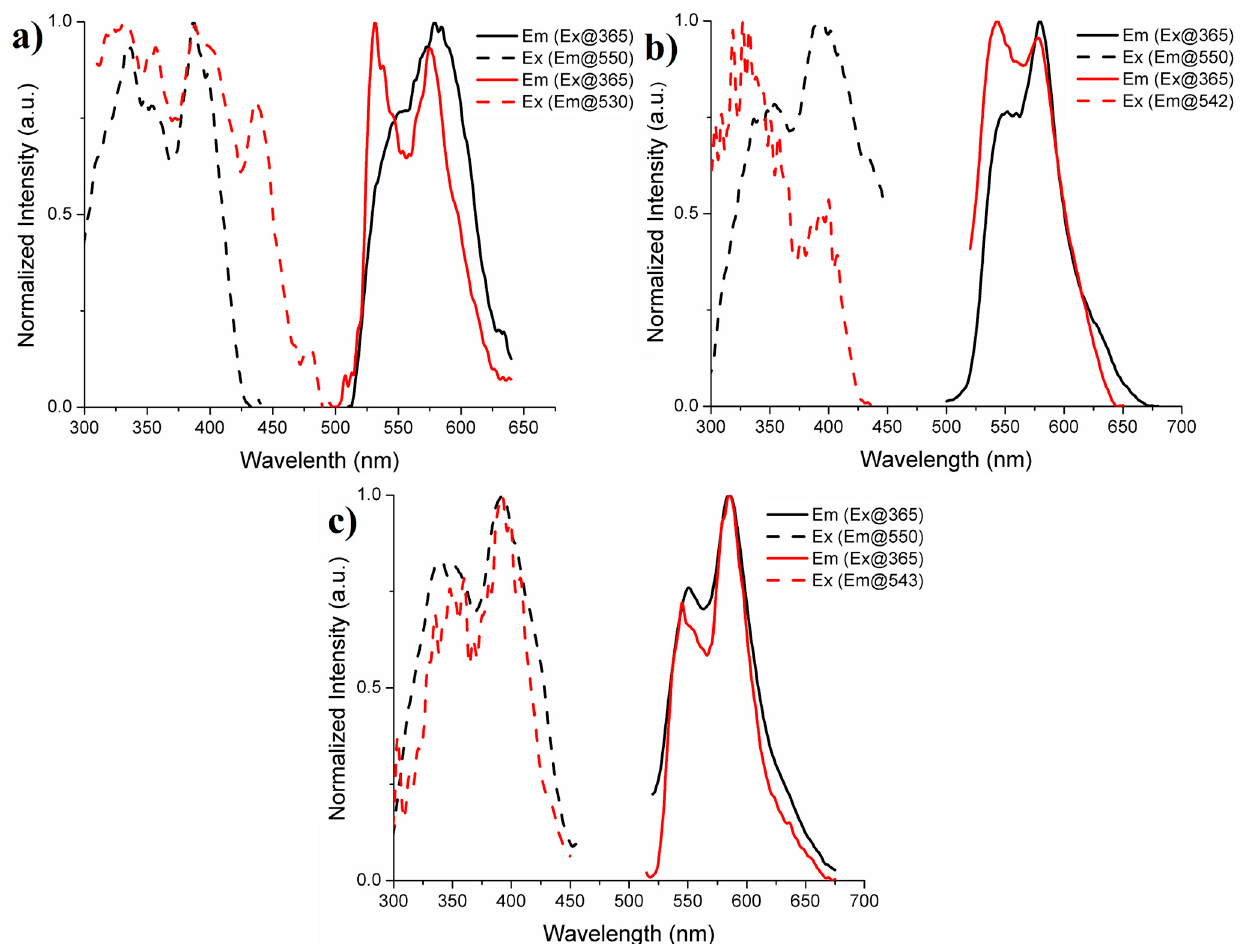
Figure 3. Emission (solid lines) and excitation (dashed lines) spectra of ( a ) 1a , ( b ) 1b and ( c ) 1c in solid state at 298 K (black)